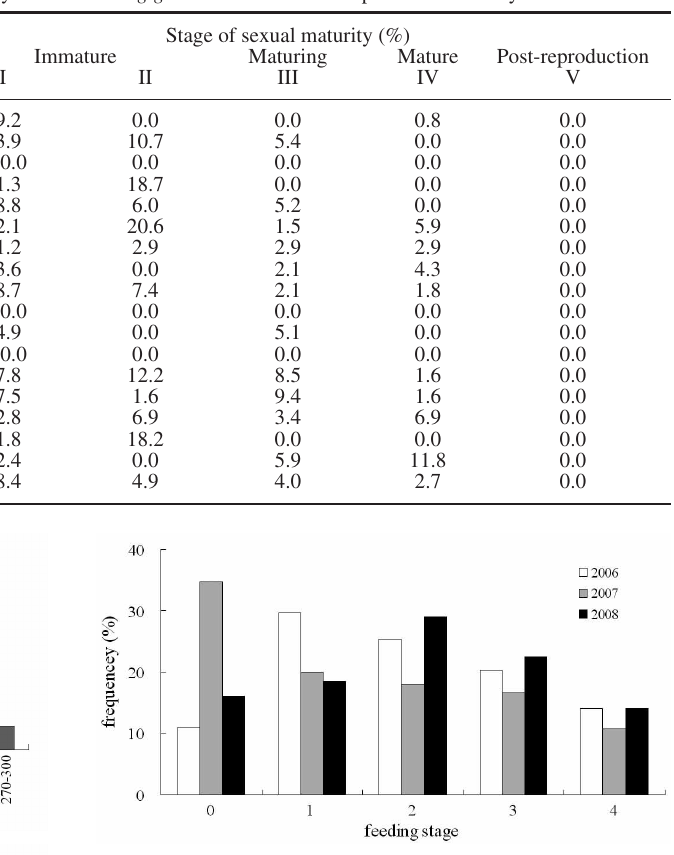
Fig . 6. – Frequencies of different feeding stages of D. gigas off